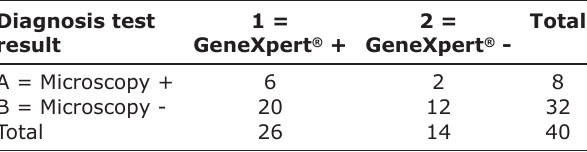
Table-3: Sensitivity, specificity, and predictive value of the microscopic test using GeneXpert® results as a reference.